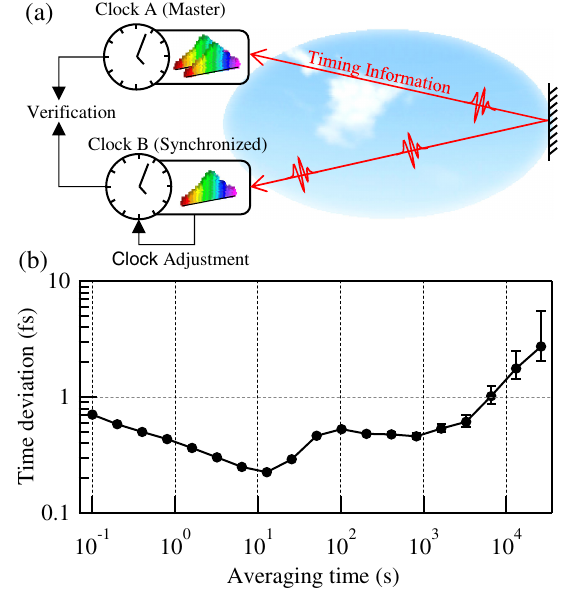
FIG. 1. (a) General synchronization concept. Time information is transmitted between sites across a turbulent air path. Real-time feedback is applied to the clock at site B to synchronize it with the clock at site A. A folded optical path allows for verification of the synchronization by a direct “ out-of-loop ” measurement. (b) Mea- sured time deviation, or precision, between the time outputs while synchronized across a 4-km link, based on data acquired over 2 days as described in Sec.